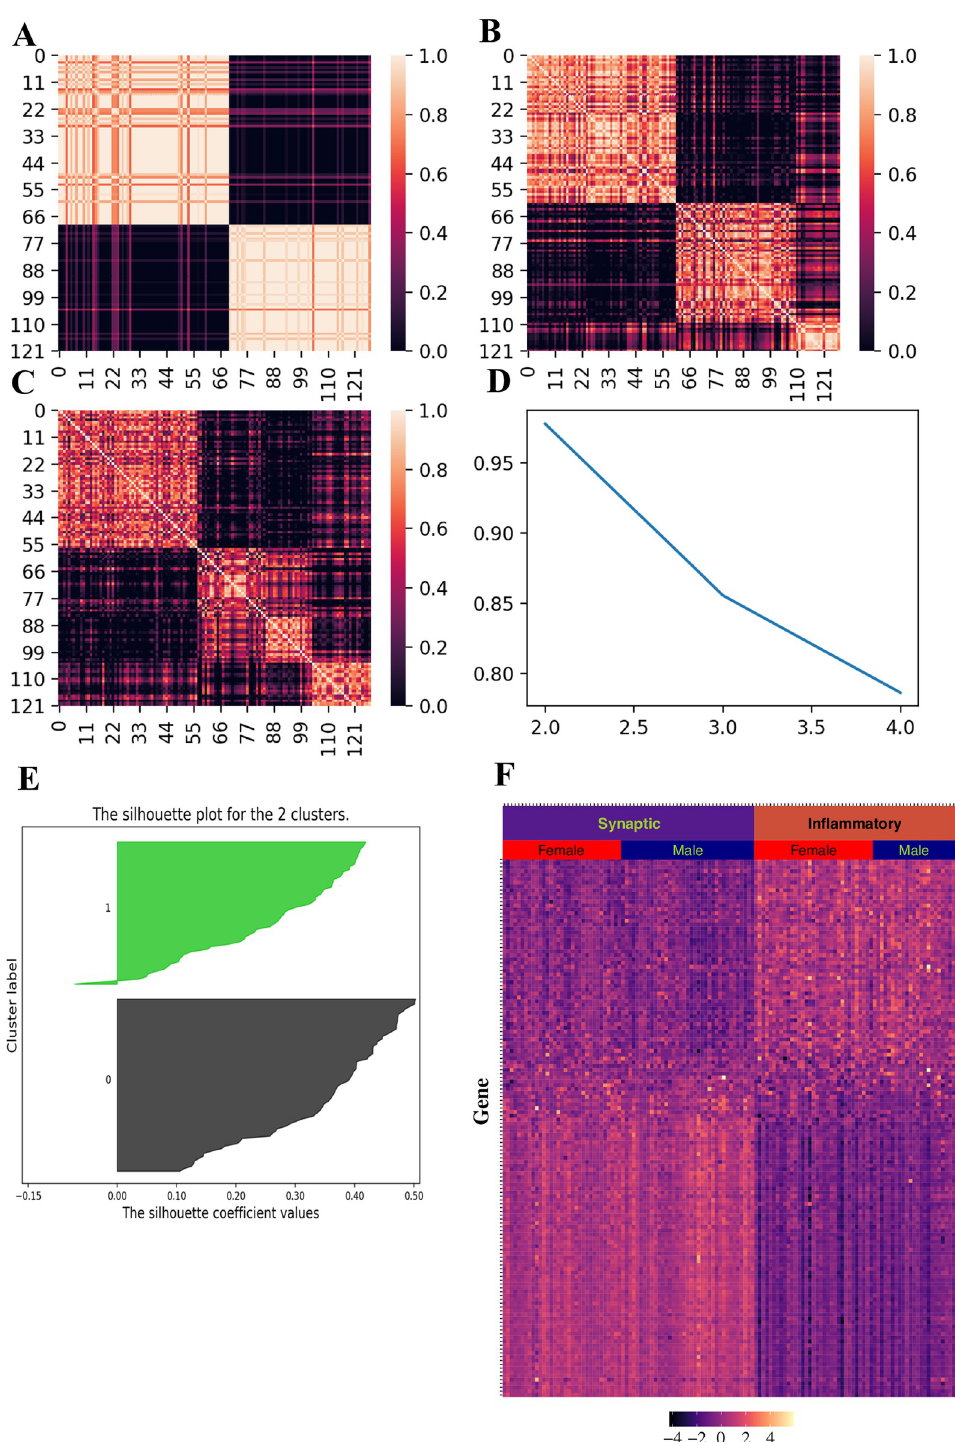
Fig 5. Molecular subtype validation in GEO dataset (GSE44770). (A-C) Consensus matrices for 2, 3 and 4 clusters respectively. (D) Plot of cophenetic correlation coefficient against the number of clusters. (E) Silhouette distance for each sample. (F) Heatmap for signature gene